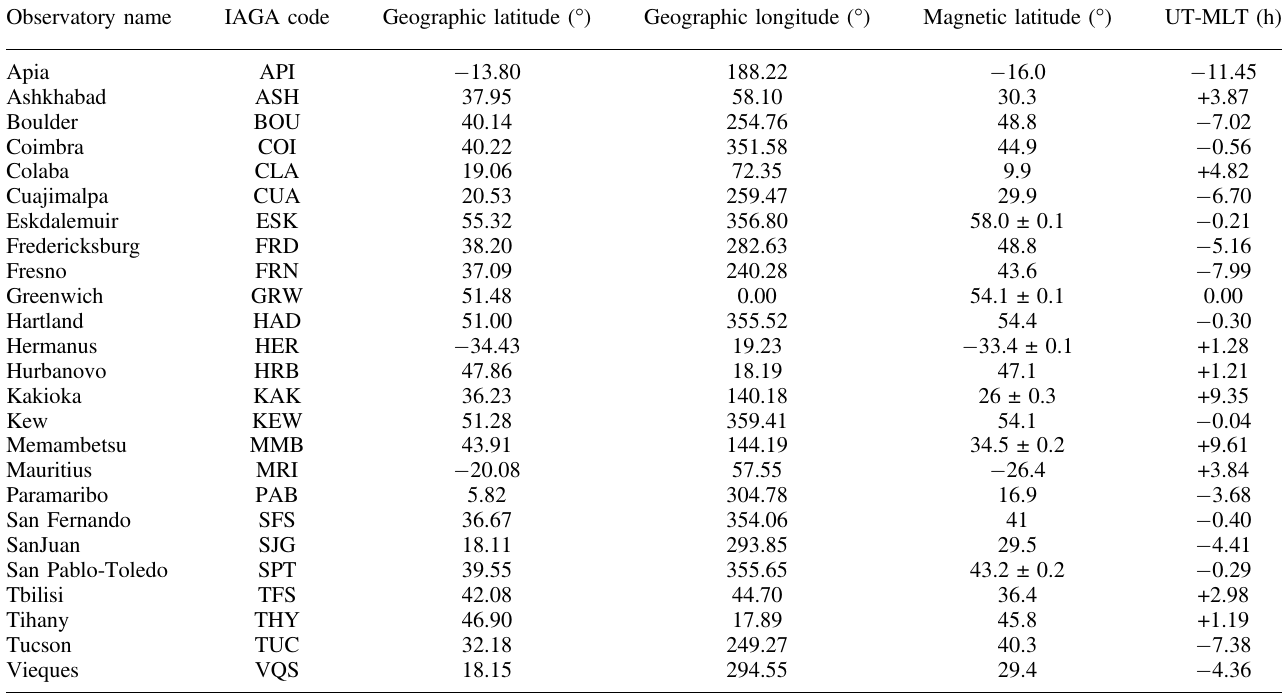
List of magnetic observatories of the analysis of the historic events (Table Table B1. Geographic and magnetic location of magnetic observatories in the analysis of the historic events (Table 1). The fi fth column refers to the magnetic latitude according to the IGRF model available closest of the year of the event (when several periods are involved, the magnetic latitude range is given). Column 6 gives information to transform from Universal Time to Magnetic Local Time.